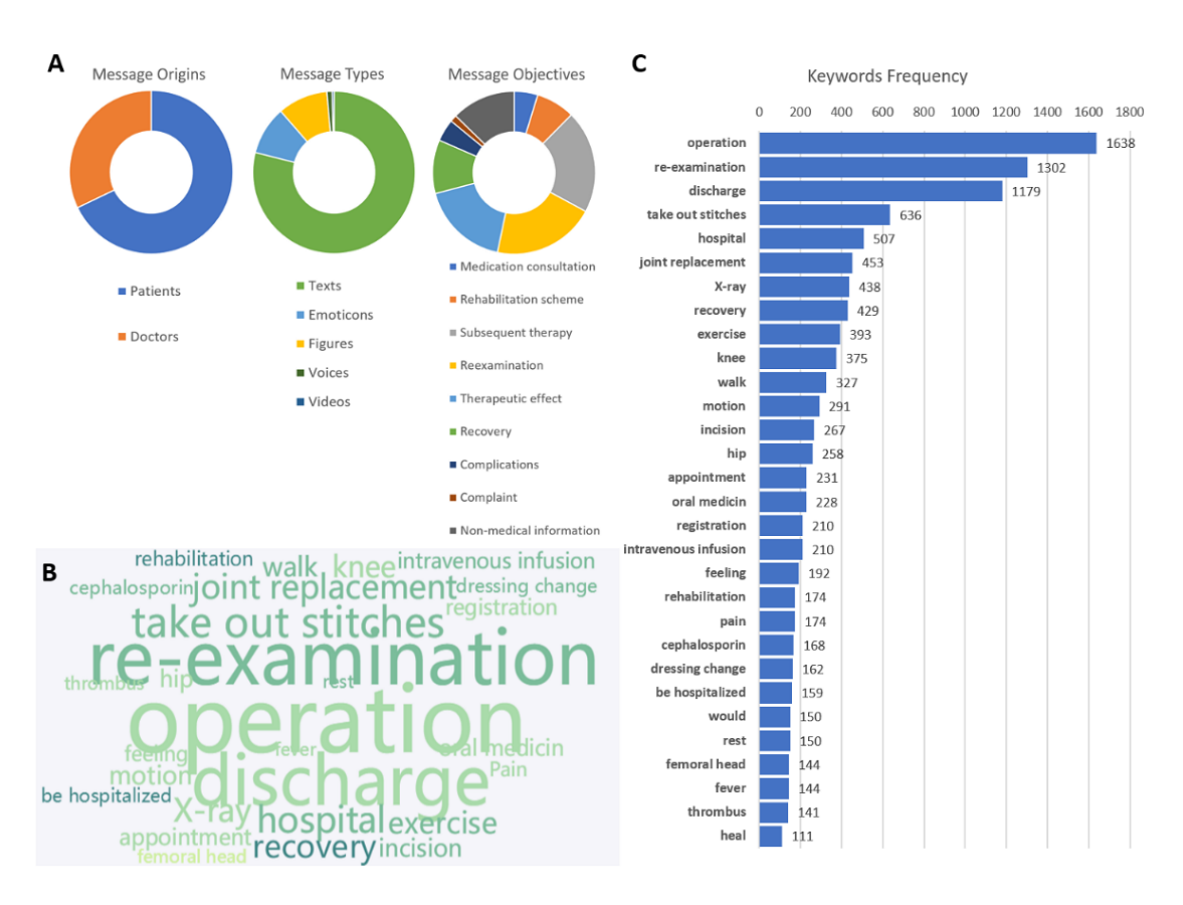
Figure 4. Text analysis of group chat records. (A) Source, classification, and purpose of the messages. (B) Word cloud of the most frequently mentioned words in the group chats. (C) Top 30 medical words that appeared in the group